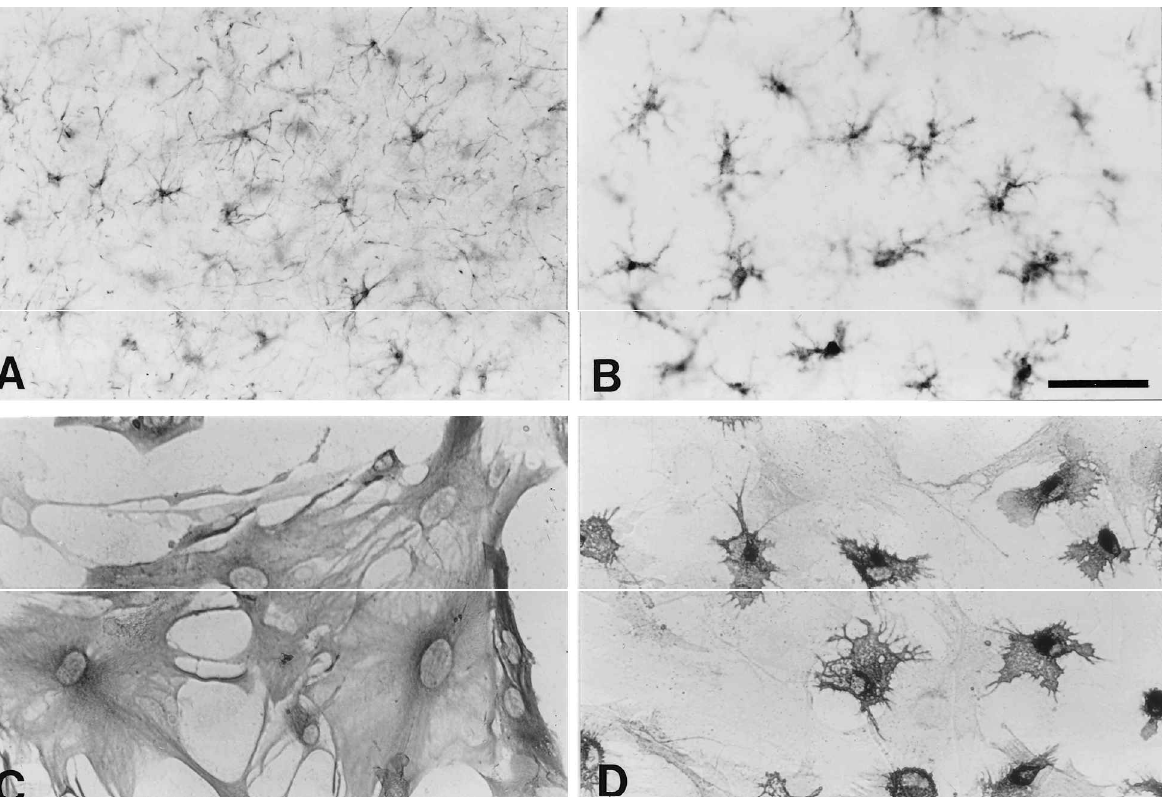
FIG. 2. Microglial cells and astroglial cells in rat brain in vivo and in vitro stained for GSA-l-B4-isolectin and GFAP respectively. ( A ) GFAP staining of astroglial cells in rat brain; ( B ) GSA-l-B4-isolectin staining ramified microglial cells in a rat brain; ( C ) GFAP in vitro in a purified astroglial cell culture; ( D ) GSA-l-B4-isolectin in vitro in a purified ameboid microglial cell culture. A, B, bar = 66mm; C,D, bar =